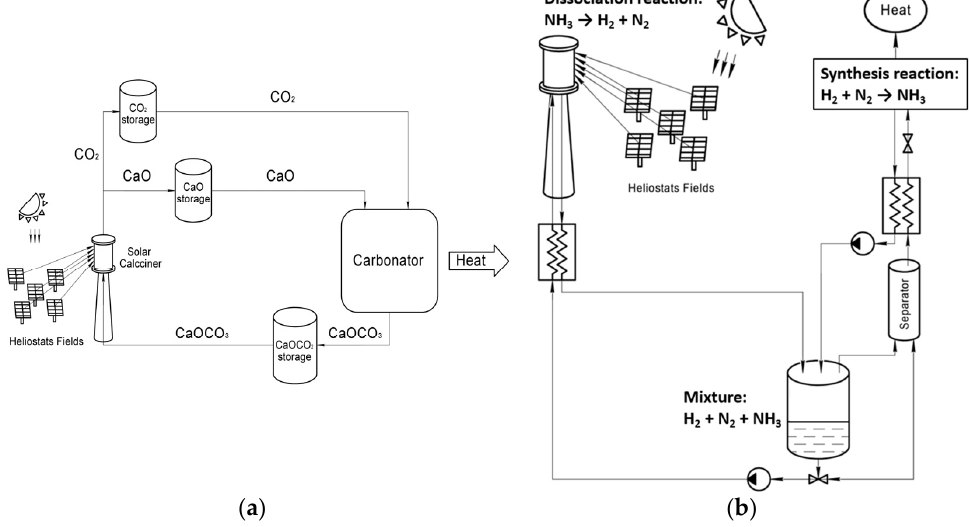
Figure 15. Thermochemical accumulation in a solar power plant: (a) calcium carbonate synthesis cycle; (b) ammonia synthesis cycle.